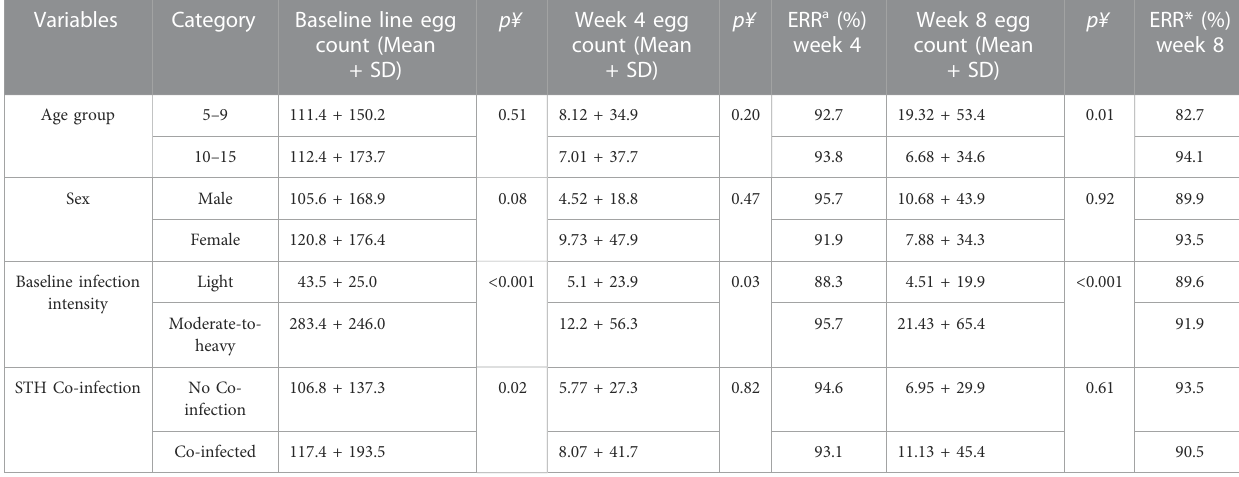
TABLE 4 The Arithmetic mean egg count at baseline and follow up visits with their respective ERR strati fi ed by baseline characteristics.